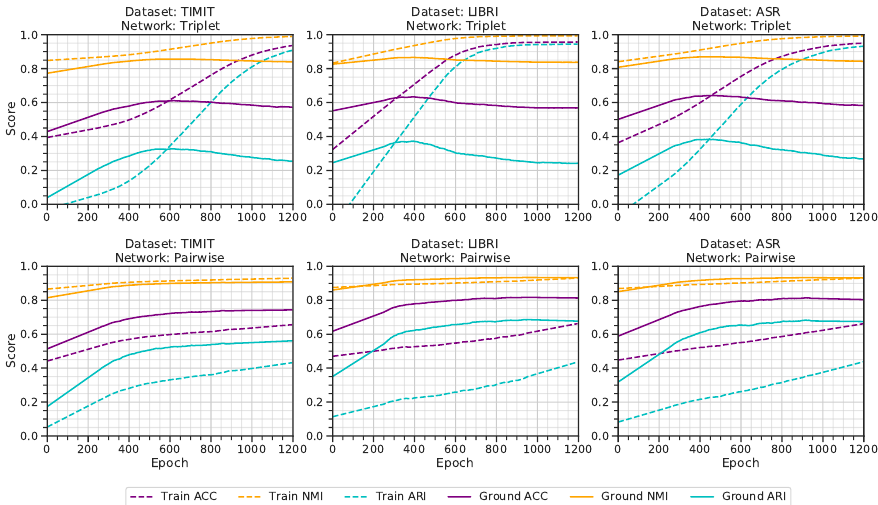
Figure 6. The graph illustrates metrics on training and ground dataset containing 50 speakers with impurity = 0.05.